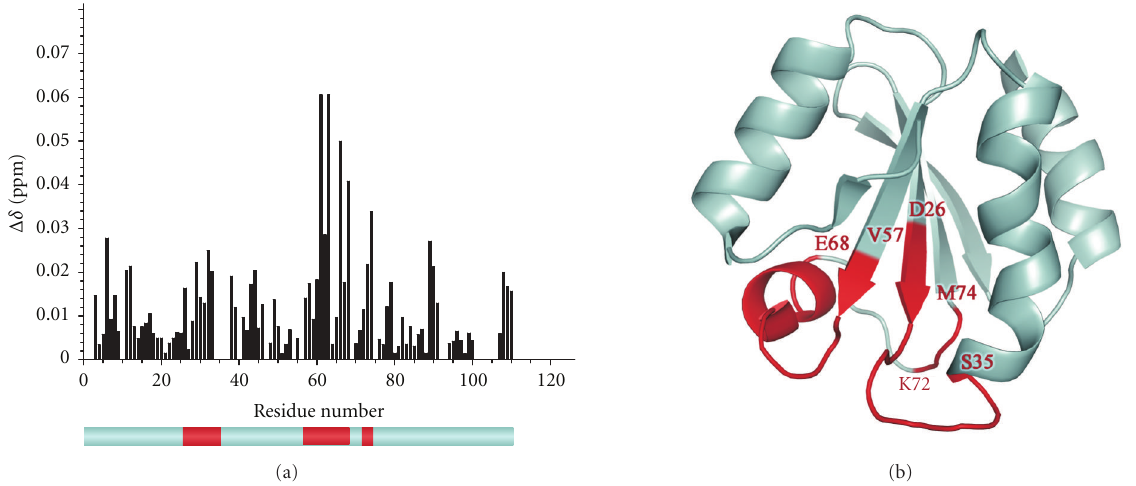
Figure 2: (a) Chemical shift di ff erence observed for each residue of Trx upon NMR titration by MsrB1. Lower panel shows in red the residues revealing maximal changes upon titration. (b) The 3D structure of oxidized mammalian Trx. “Hot points” used for molecular docking are evidenced in